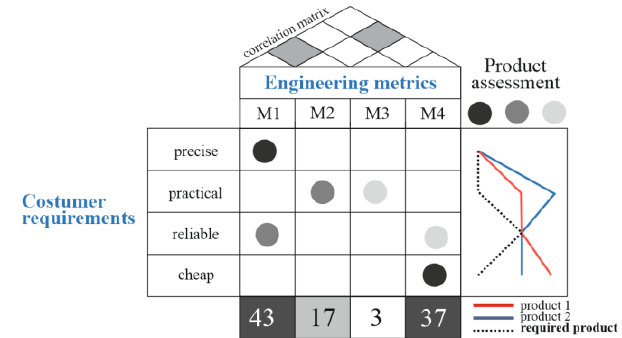
Fig. 7. The first stage of structuring the “Quality Factor Deployment”